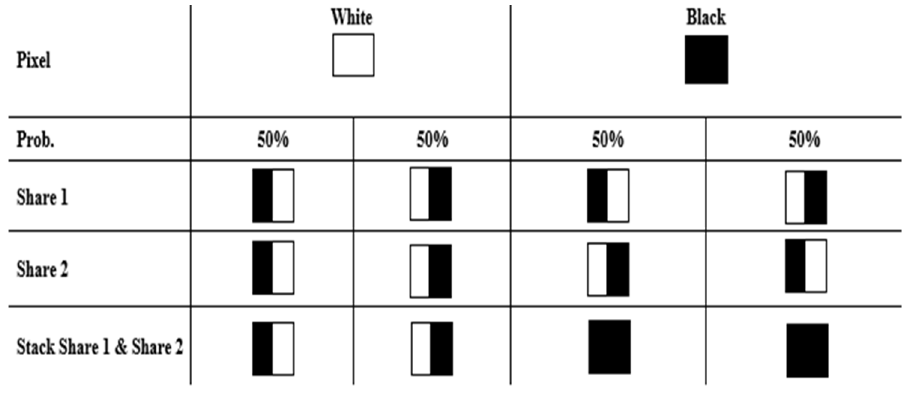
Figure 1. Visual cryptography scheme for (2,2) construction [34].